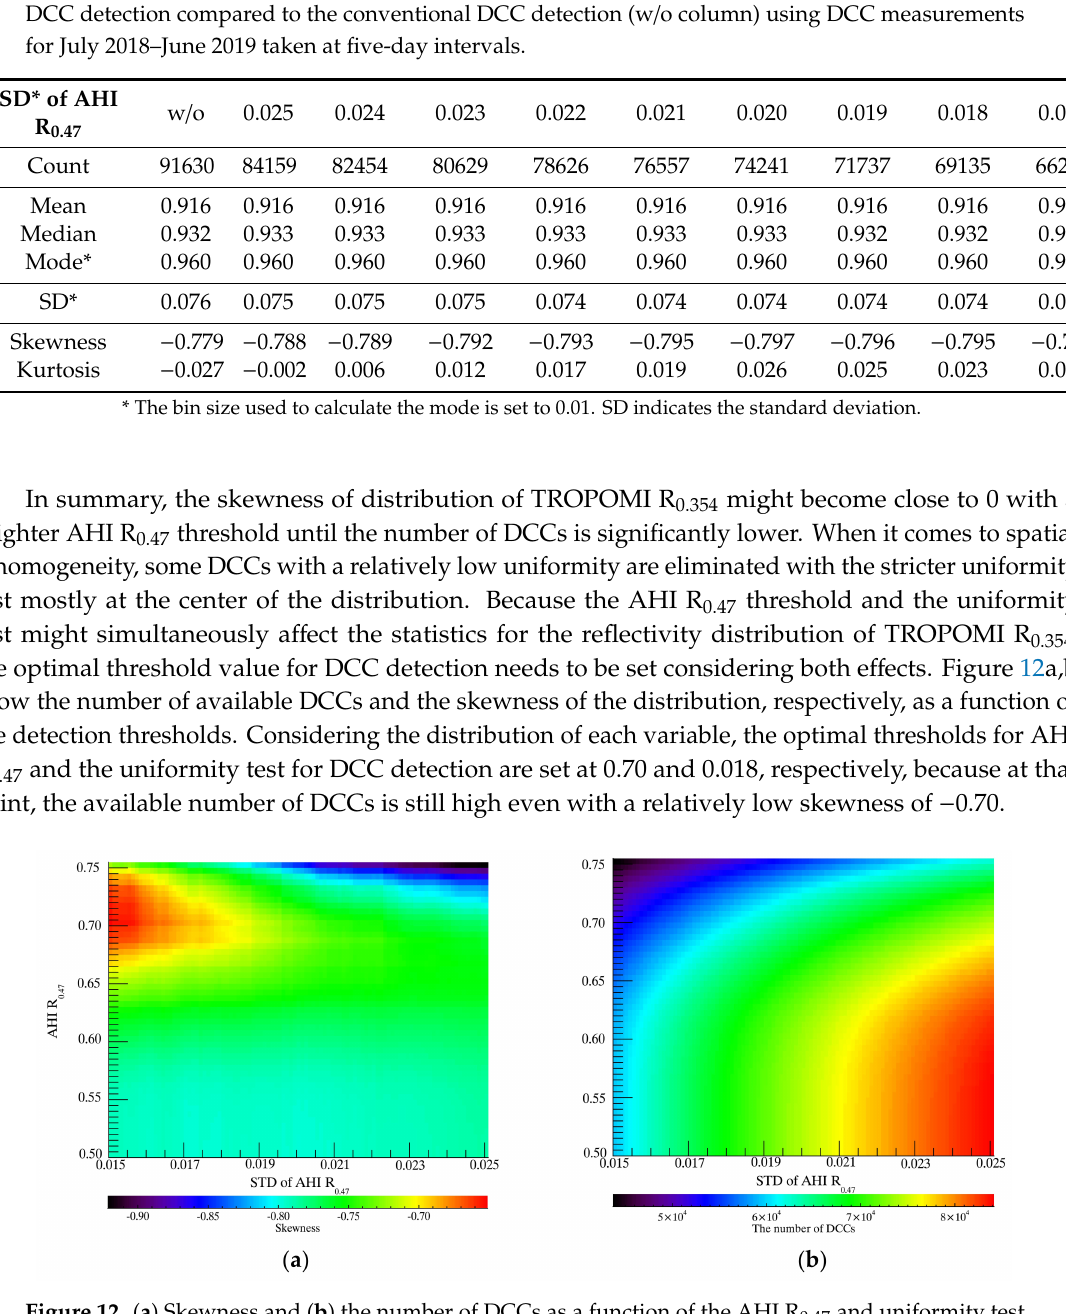
Table 5. Statistics for TROPOMI DCC R 0.354 depending on the uniformity threshold for AHI R 0.47 for DCC detection compared to the conventional DCC detection (w / o column) using DCC measurements